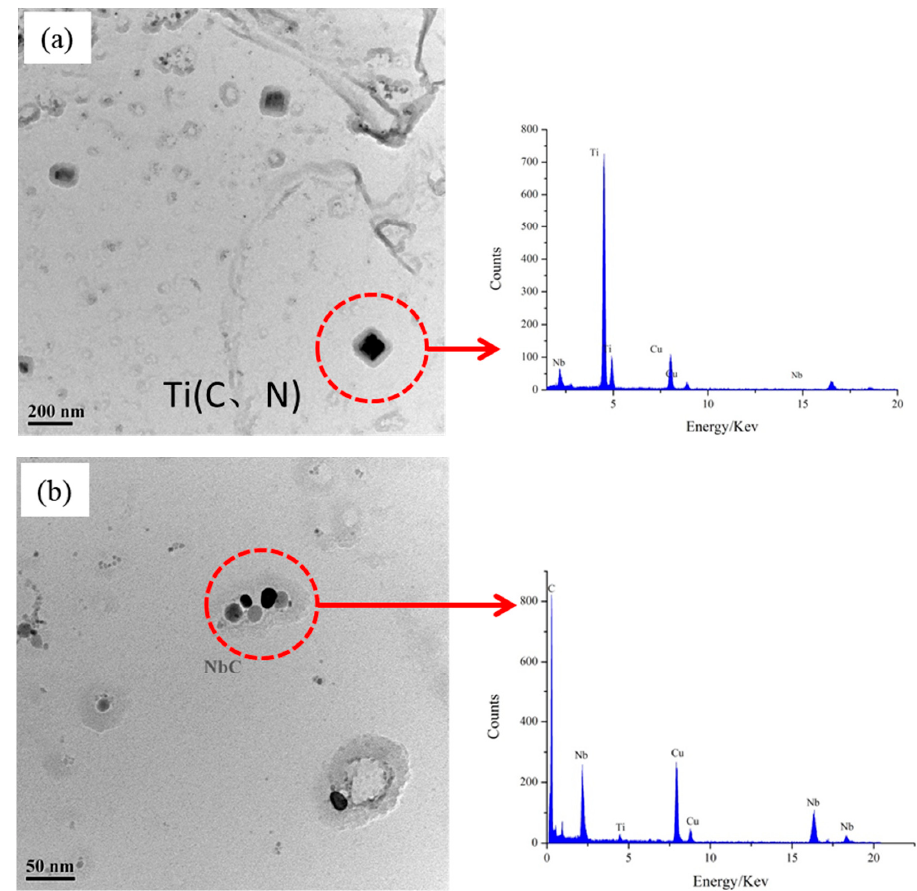
Figure 4. TEM figures basing on the carbon extraction replicas of the tested steel: ( a ) Ti(C, N); ( b ) NbC precipitation.